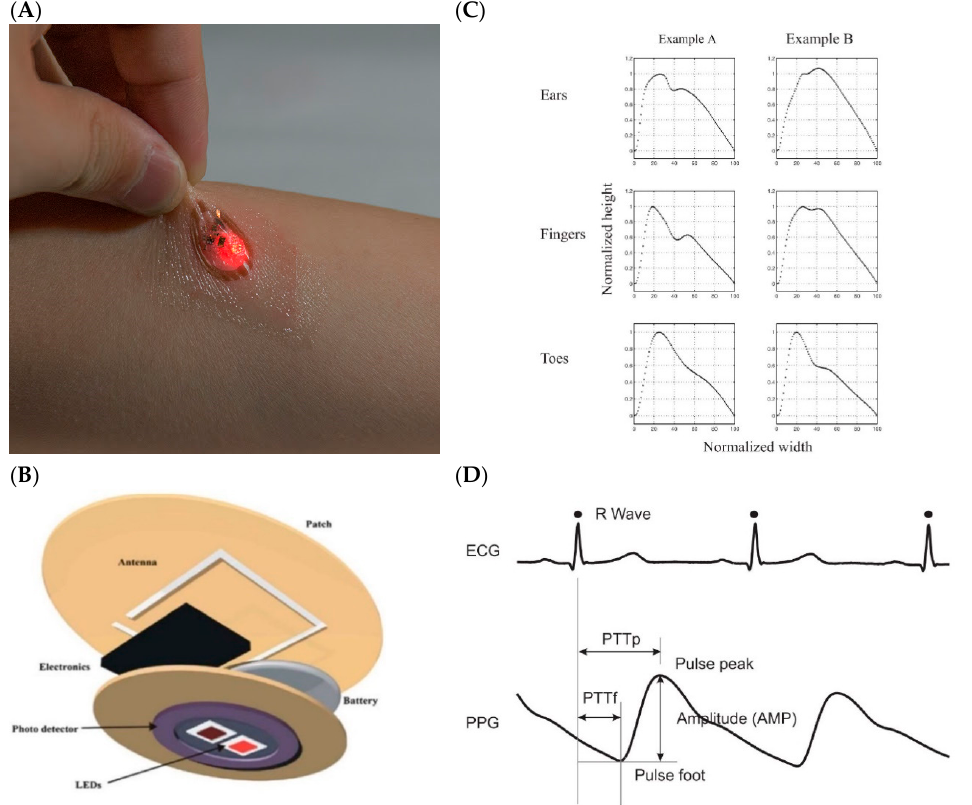
Figure 6. ( A ) Optical sensor mounted on skin, ( B ) Basic diagram of a wireless photoplethysmography (PPG) sensor, ( C ) PPG signal collected from three different locations, ( D ) Comparison of the PPG signal with ECG signal.